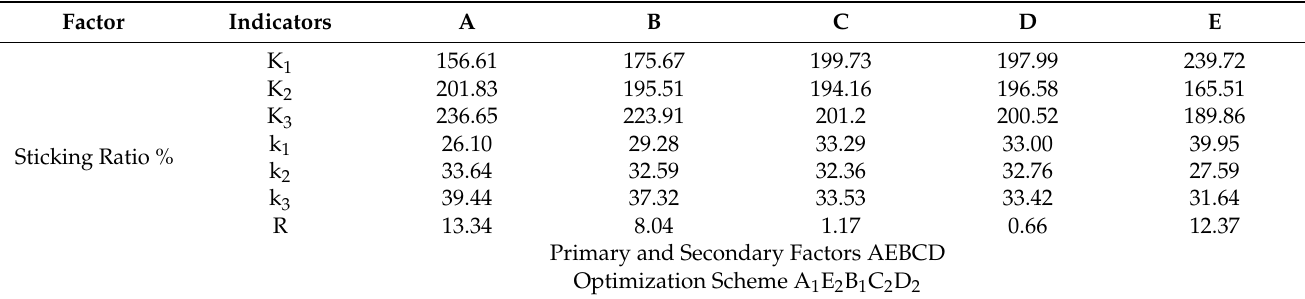
Table 6. Result analysis of sticking ratio.